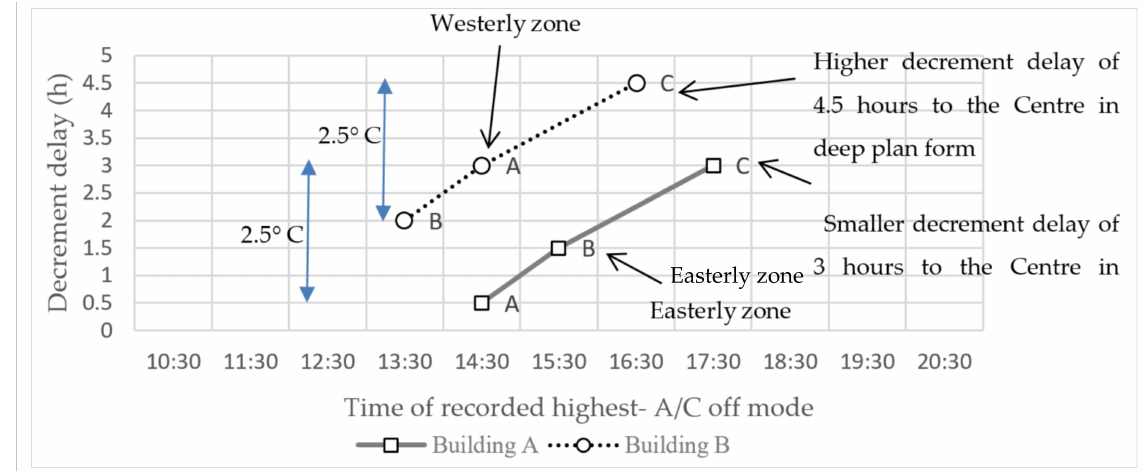
Figure 13. Equal decrement delays of air temperature from perimeter zones (A and B) to the Center (C) in shallow (Building A) and deep plan (Building B) forms in non-AC modes.